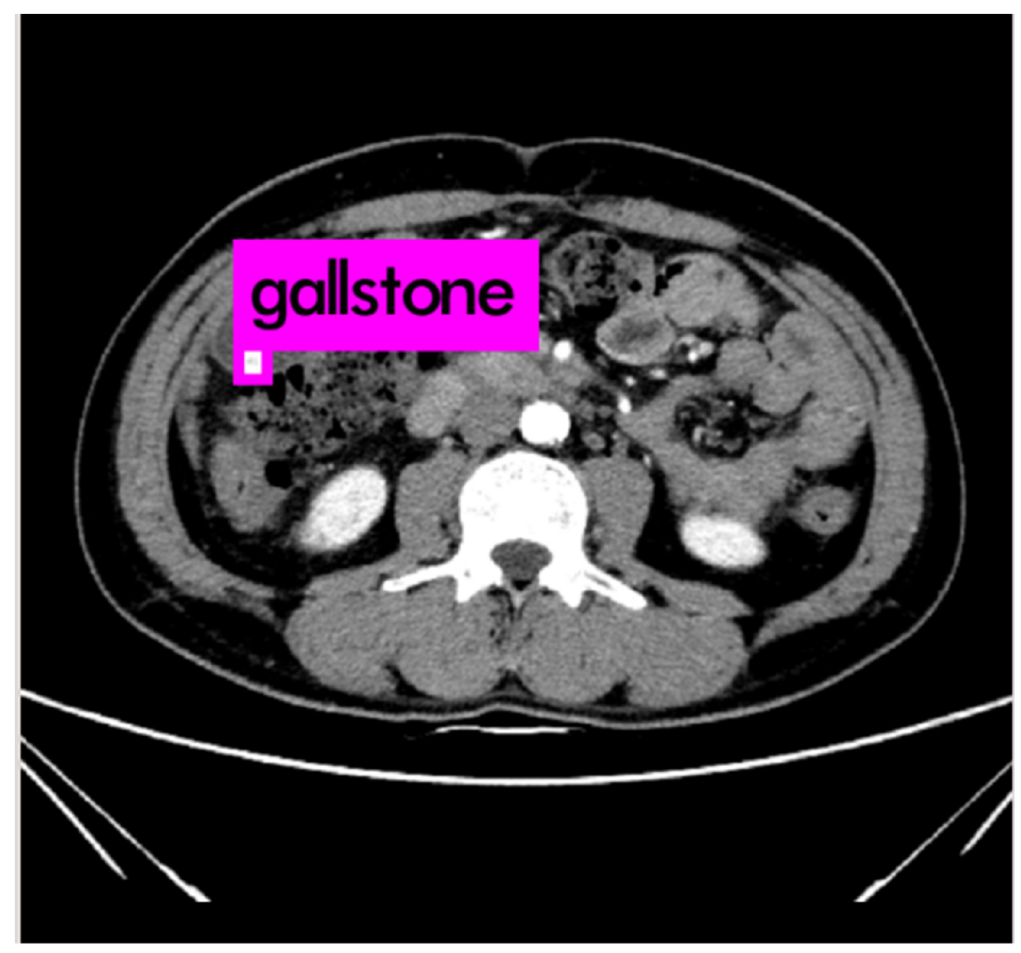
Fig 10. The CT image with the lesions discerned. https://doi.org/10.1371/journal.pone.0221720.g010 Table 5. Performance comparison of MobileNetV2 + SSDLite and other realtime detectors on the cholelithiasis dataset.